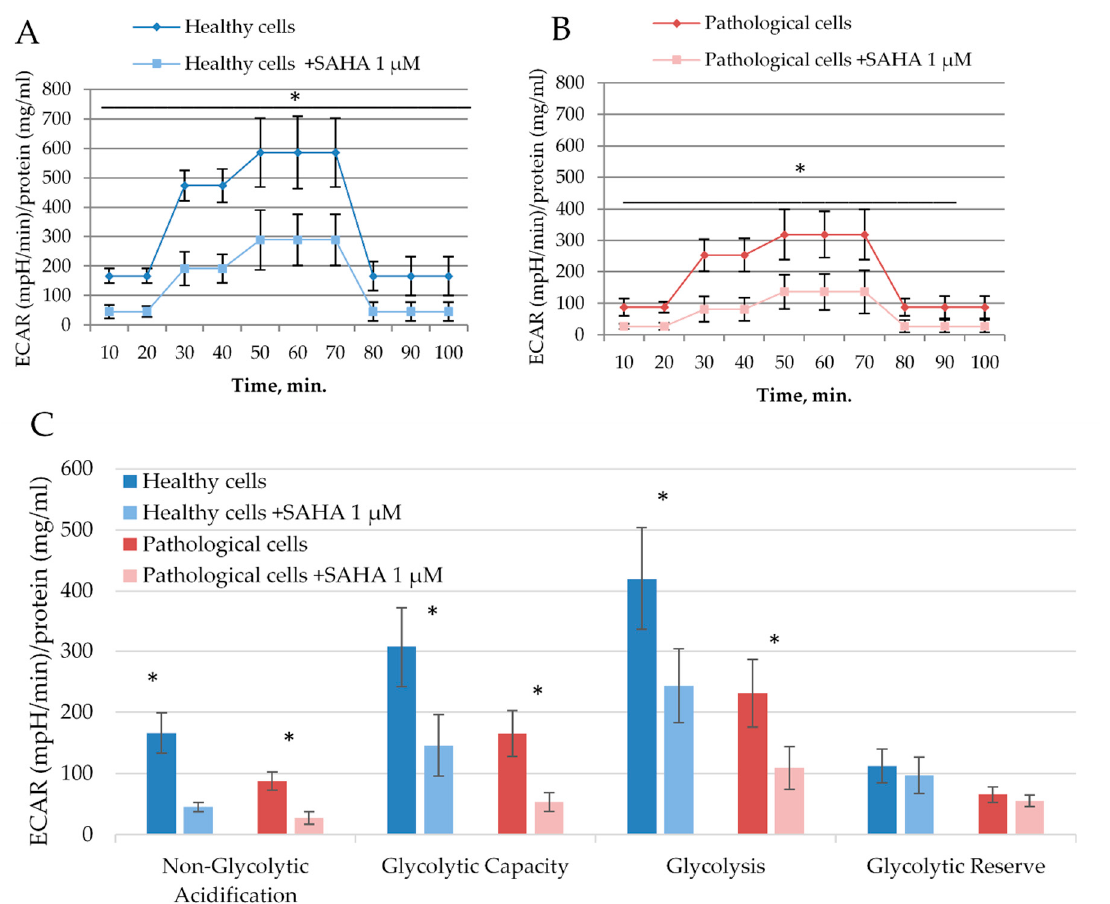
Figure 6. The effect of SAHA on glycolysis of healthy and pathological hmMSC. Decrease of extracellular acidification rate (ECAR) ((mpH/min)/protein (mg/m)) in healthy cells ( A ) and pathological ( B ) cells after exposure to 1 µM of SAHA for three days. ( C ) Quantification of glycolytic stress parameters in healthy and pathological hmMSC with and without SAHA. Data are shown as mean ± standard deviation (SD). The * p ≤ 0.05, n = 3 from three experiments. Student t -test was calculated by an Excel program.